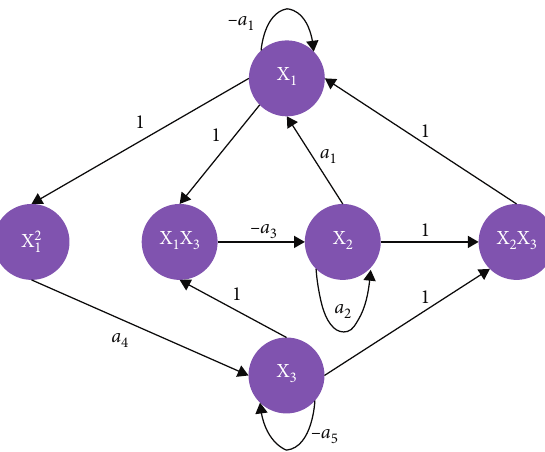
Figure 4: Proposed signal flow graph of the proposed chaotic system.